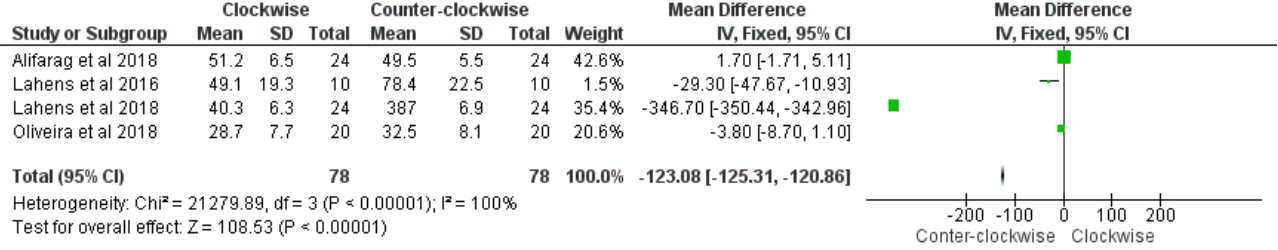
Figure 12. Forest plot of comparison of BIC percentage, of the clockwise procedure (right) and counter-clockwise procedure (left).